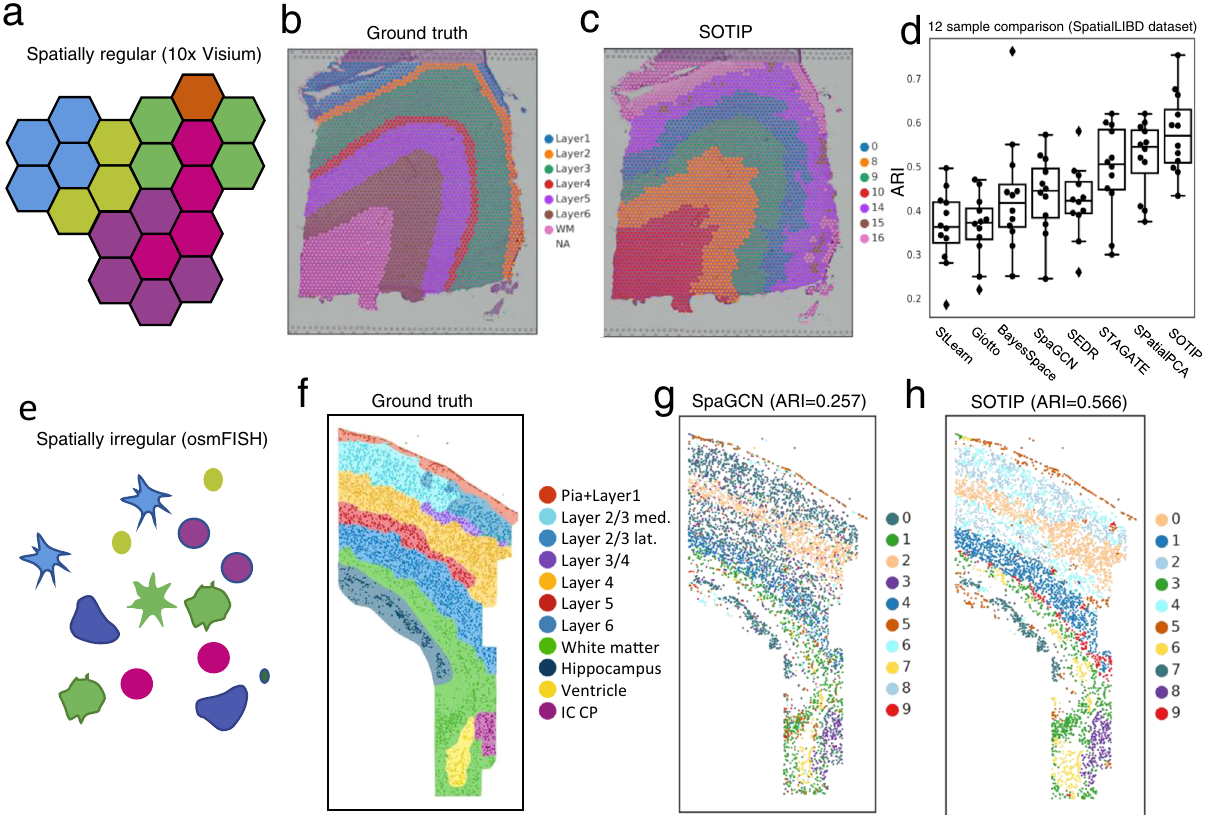
Fig. 4 | SOTIP strati fi es known layers in brain tissues. a – d Human dorsolateral prefrontal cortex dataset with 10x Visium. a Spatial arrangement illustration for typical 10x Visium dataset. b Ground truth annotation for slice 151673. c Spatial domaindetectedbySOTIP.ThelabelsarenotconsecutivebecauseSOTIPfollowsa hierarchical merging scheme. d Boxplots summarize the detection accuracy ( y -